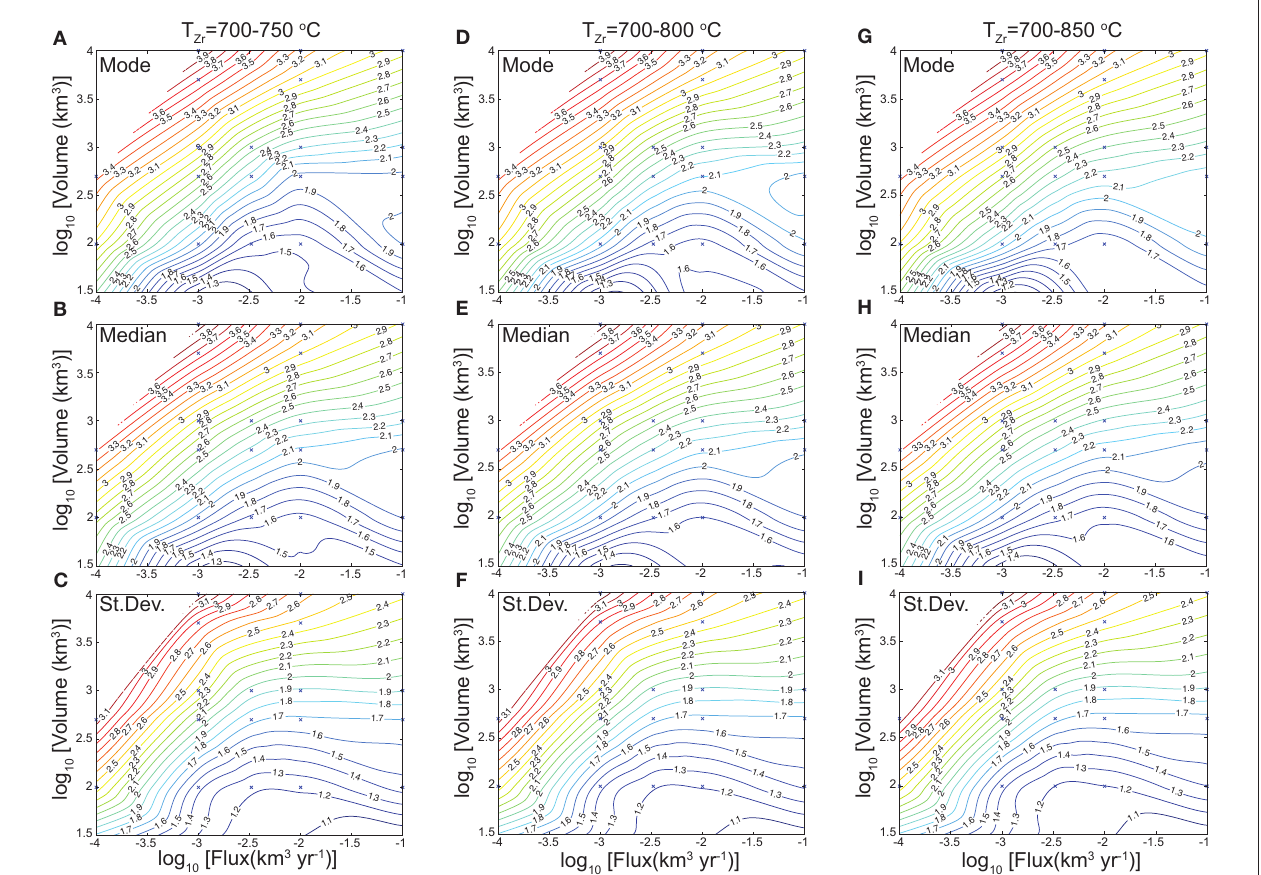
FIGURE 6 | Contours of mode (A,D,G), median (B,E,H), and standard deviation (C,F,I) for zircon age spectra obtained from thermal modeling. The number within the contours shows the logarithmic values of the respective parameters in kilo-years. Values presented in (A–C) were obtained for a range of zircon crystallization temperature (T zr ) of 700–750 ◦ C, (D–F) for T zr between 700 and 800 ◦ C, and (G–I) for T zr between 700 and 850 ◦ C.